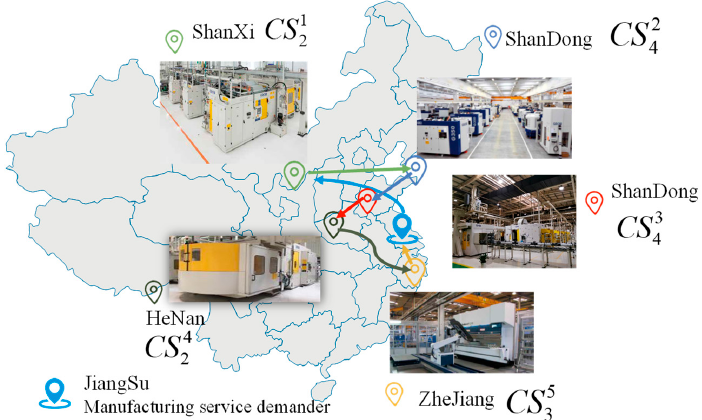
Figure 10. The transportation route of the CMfg solution.